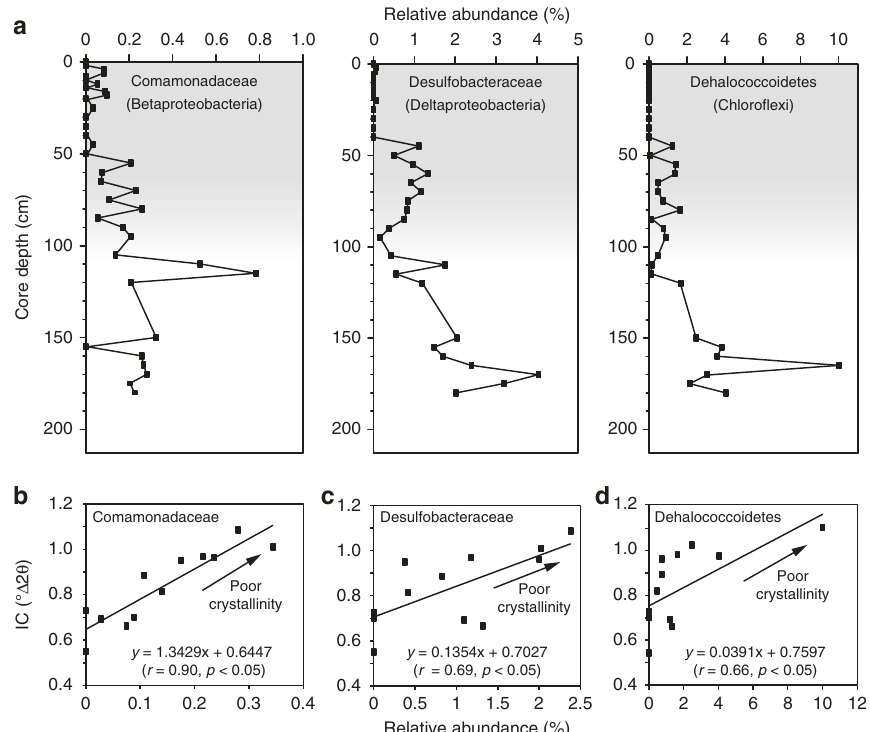
Fig. 5 Distribution and abundance of putative Fe-reducing bacteria with illite crystallinity. a Distribution of major groups in core EAP13-GC16B with depths (shaded areas suggest that oxic condition with occasionally open sea). Correlations of bacterial groups b Comamonadaceae , c Desulfobacteraceae , and d Dehalococcoidetes with illite crystallinity